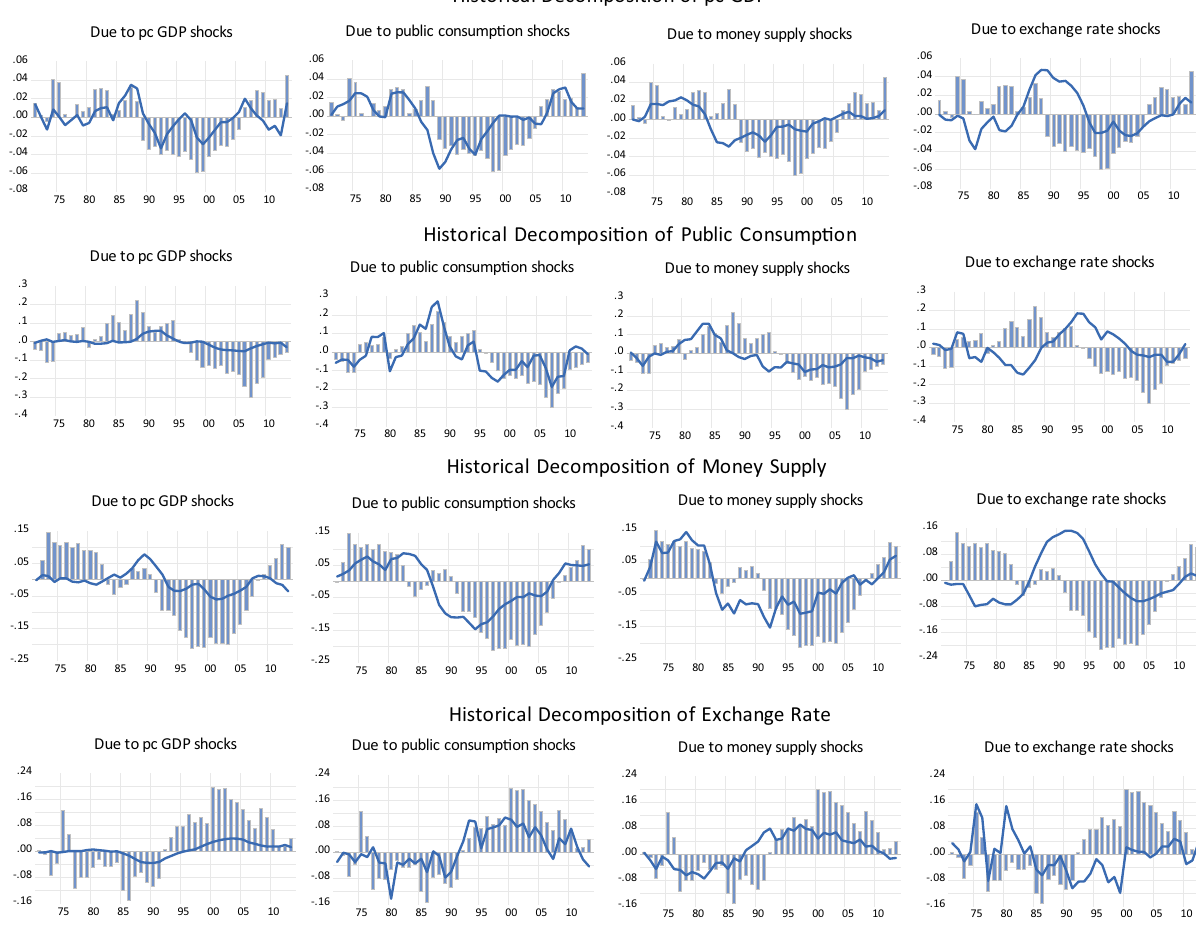
Figure 8: Historical decomposition ( Italy )